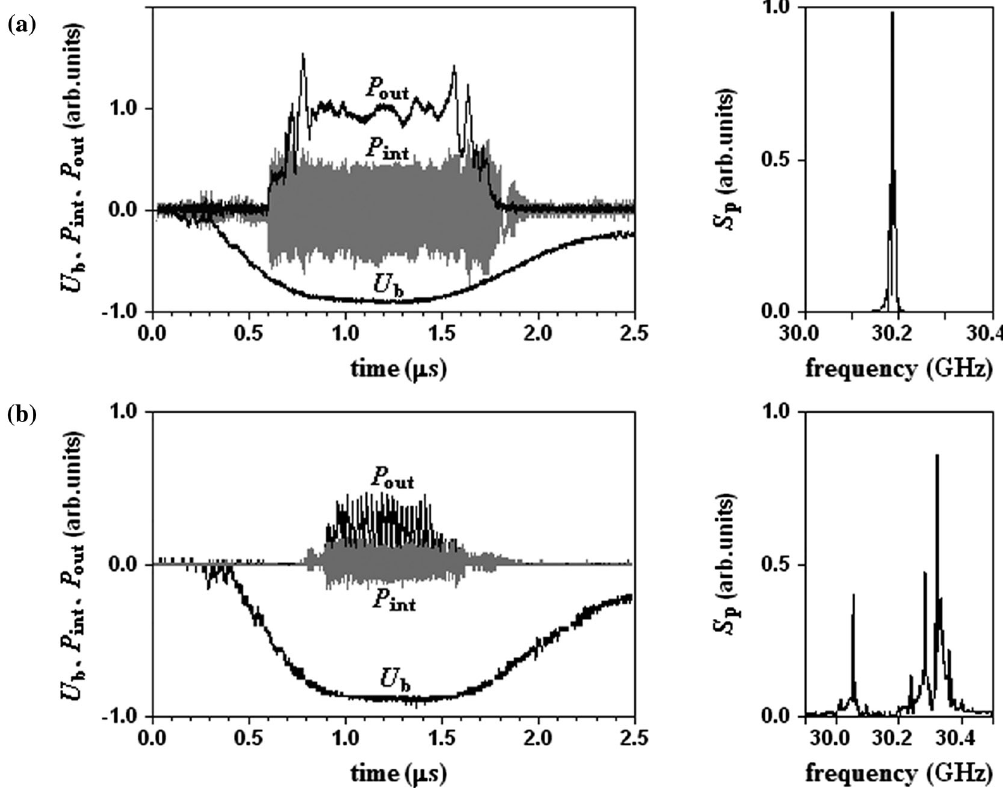
FIG. 10. Typical oscilloscope traces of diode voltage U , rf-pulse P and heterodyne signal P (left column) and the corresponding b out int frequency spectrum S (right column) in Ka-band coaxial BWO with a 2D Bragg synchronizer driven by the Saturn accelerator: p (a) narrow-band oscillation regime with the beam parameters 260 keV = 50 A; (b) multifrequency oscillation regime with the excitation of different azimuthal and longitudinal modes with the beam parameters 200 keV = 90